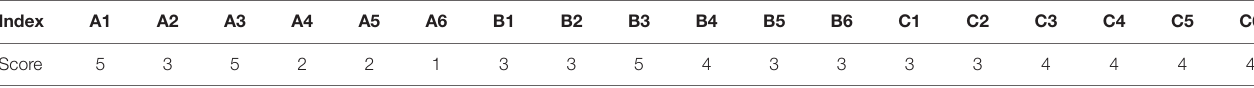
TABLE 4 | Evaluation table of managers and experts of a food manufacturing